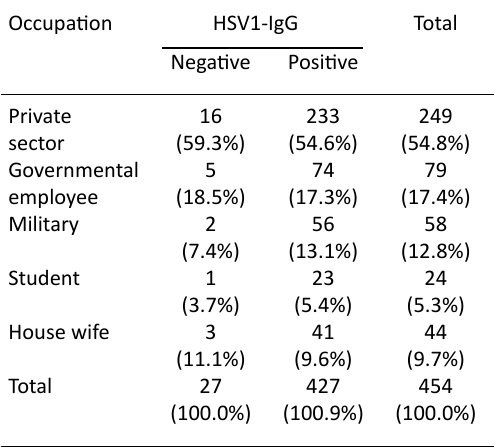
Table 3. HSV-1 Seroprevalences in Iraqi healthy blood donors, grouped according to occupation